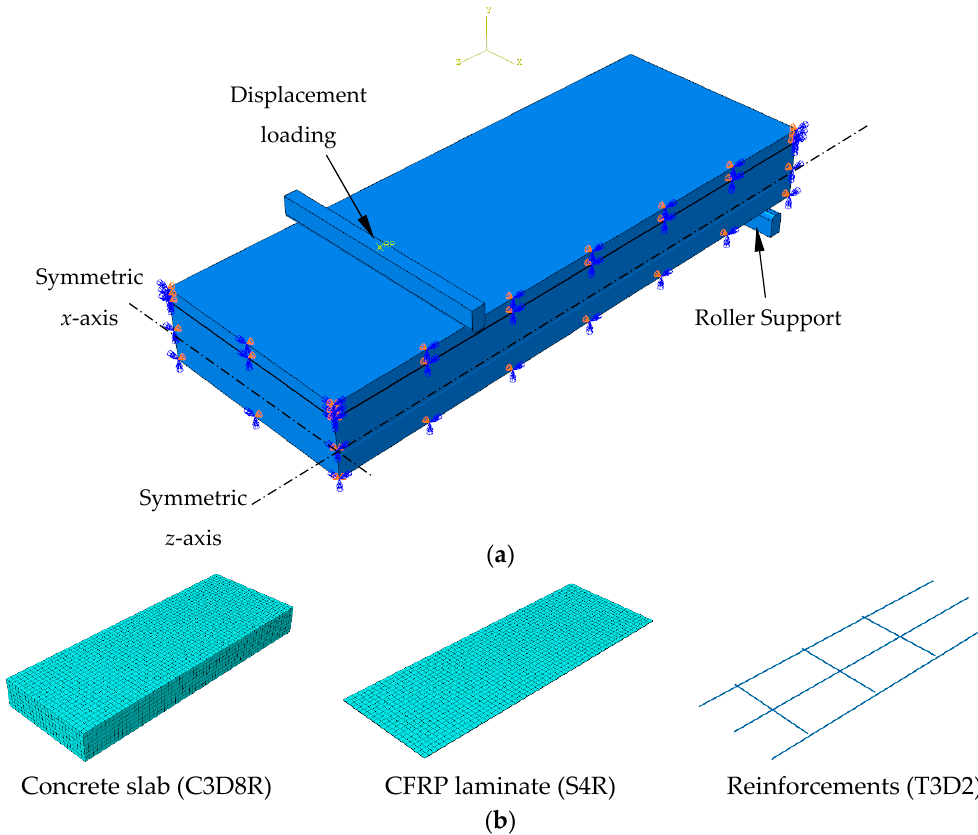
Figure 5. CFRP retrofitted slab ( a ) modeling and boundary conditions; ( b ) element types of the FEM model.